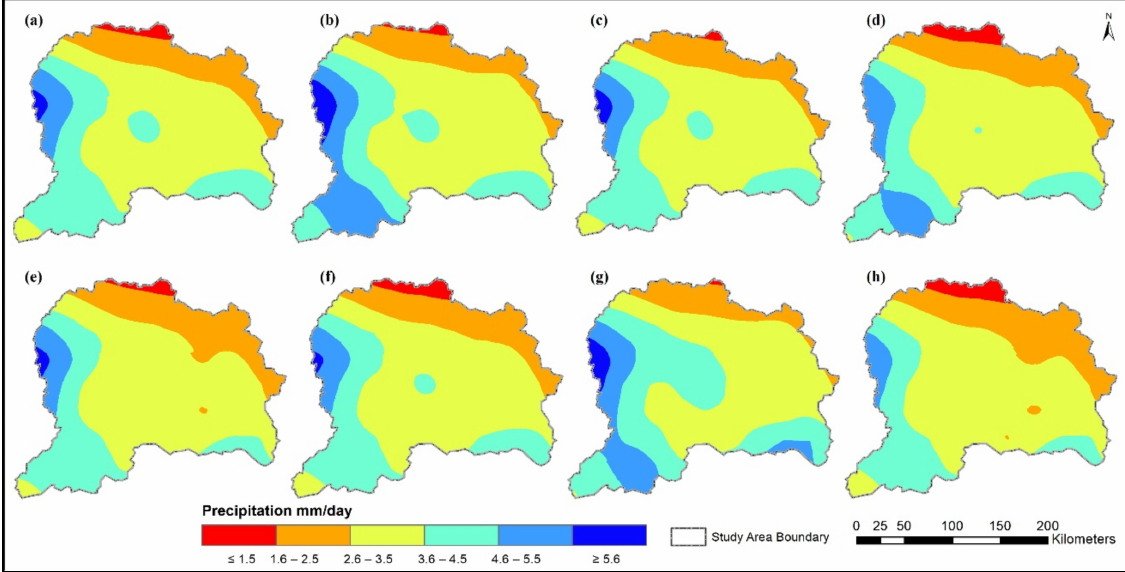
Figure 4. Spatial projections of precipitation (mm/day): ( a ) CCSM4 RCP-4.5 2021–2060; ( b )